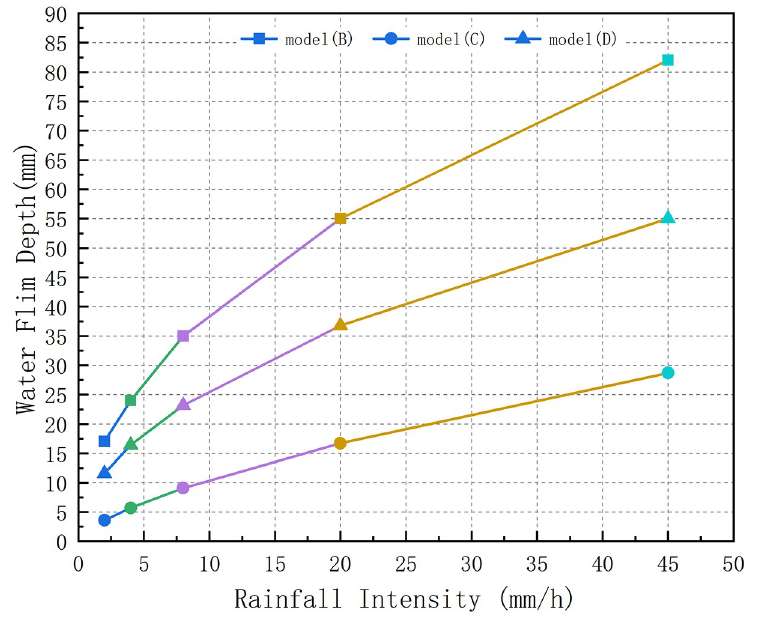
Fig 10. Relationship between the water film depth and rainfall